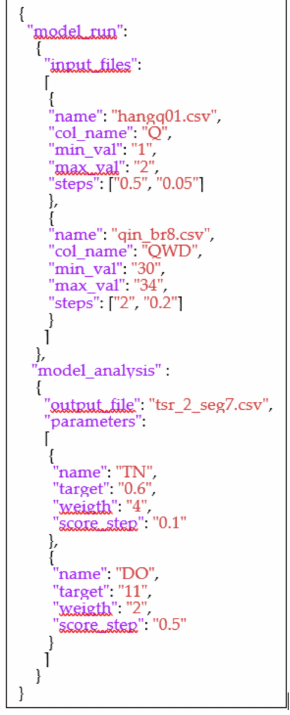
Figure A2. Example input file. Note: Two different model files are changed for the permutations, and a single recursive step is defined. The algorithm analysis considers two output parameters with different “weight” and “score_step”